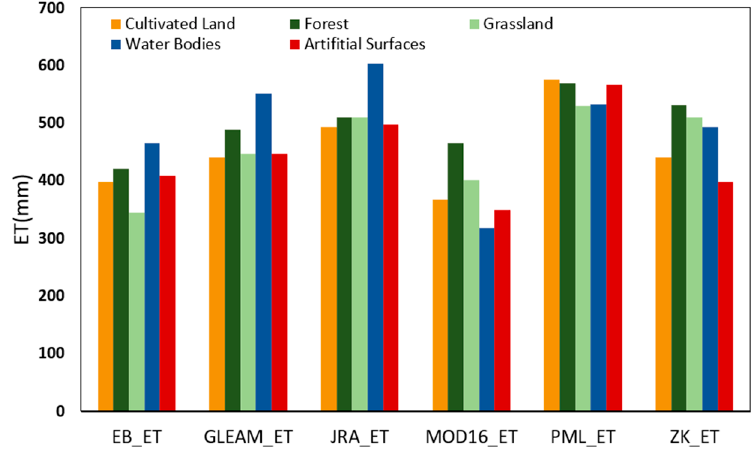
Figure 13. Annual mean ET of different land-cover types in 2003-2012.